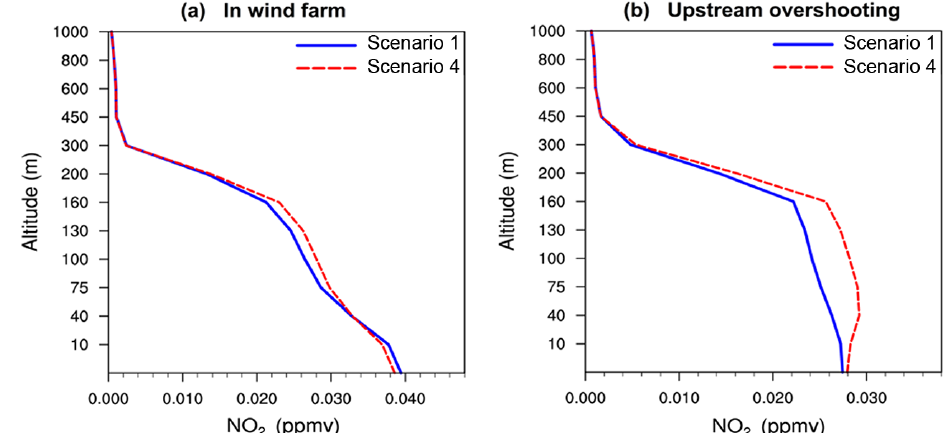
Figure 13. Vertical profiles of NO 2 concentration from the first vertical model level above the surface to the 1000m height from the control run (S1, solid blue line) and S4 run (red dashed line) at (a) the YWF grid (44, 52) at 21:00UTC on 19 November, and (b) the upwind grid (50, 48) at 22:00UTC on 19 November.